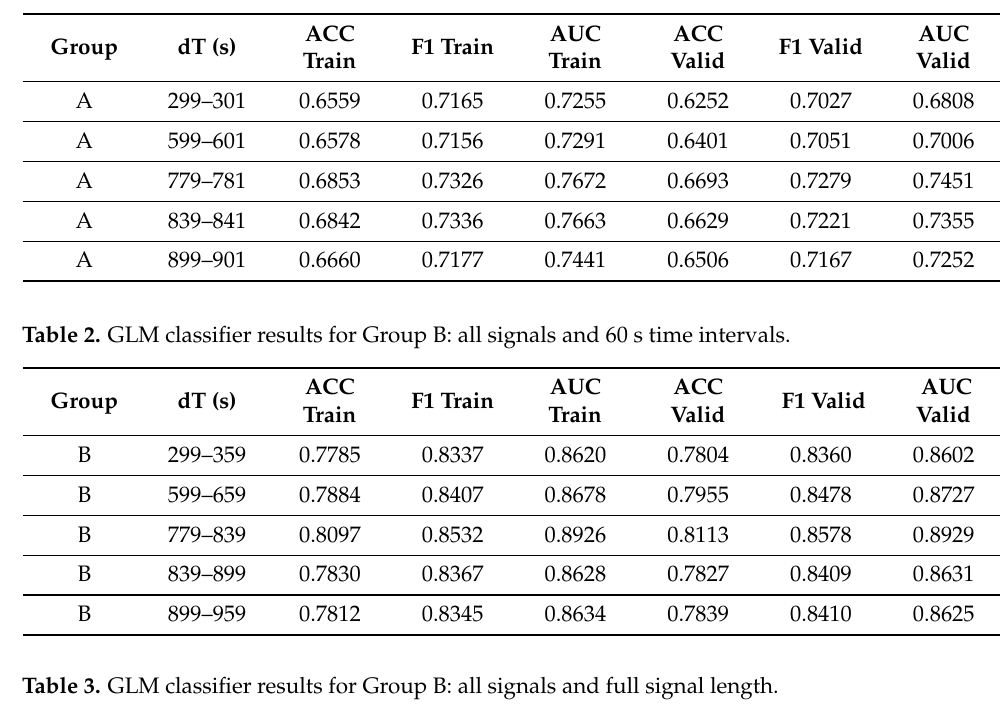
Table 1. GLM classifier results for Group A: all signals and 3 s time intervals.